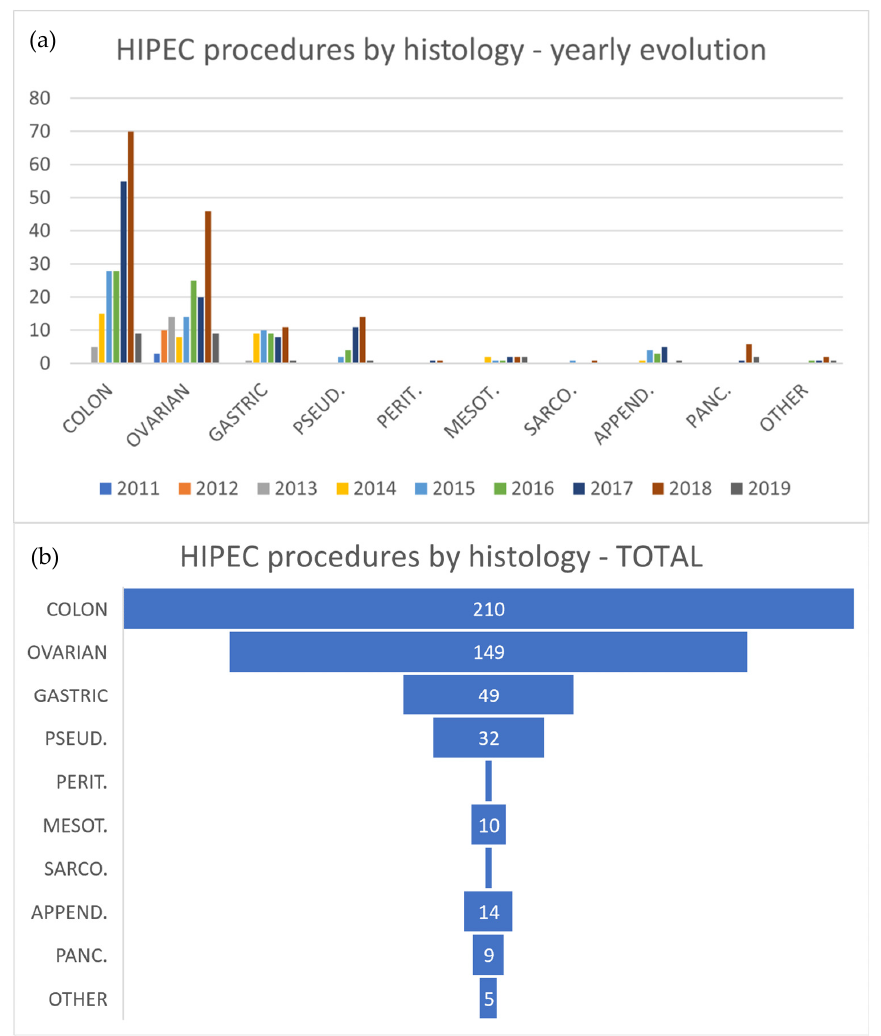
Figure 2. ( a ) Histology: yearly evolution of HIPEC procedures. ( b ) Total HIPEC procedures by histology.